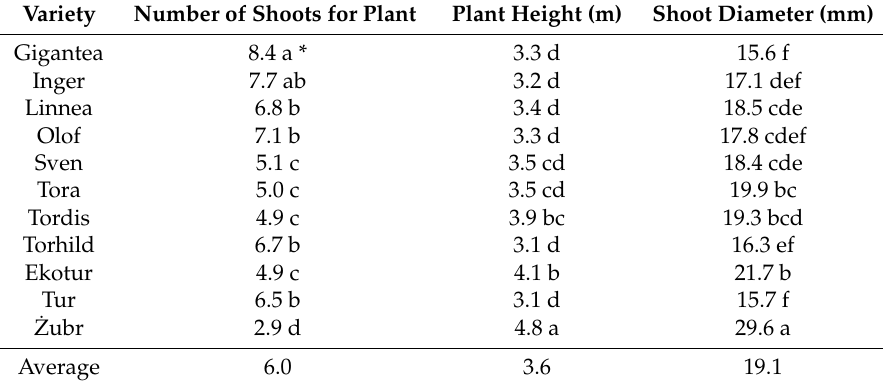
Table 3. Biometric features of tested willow